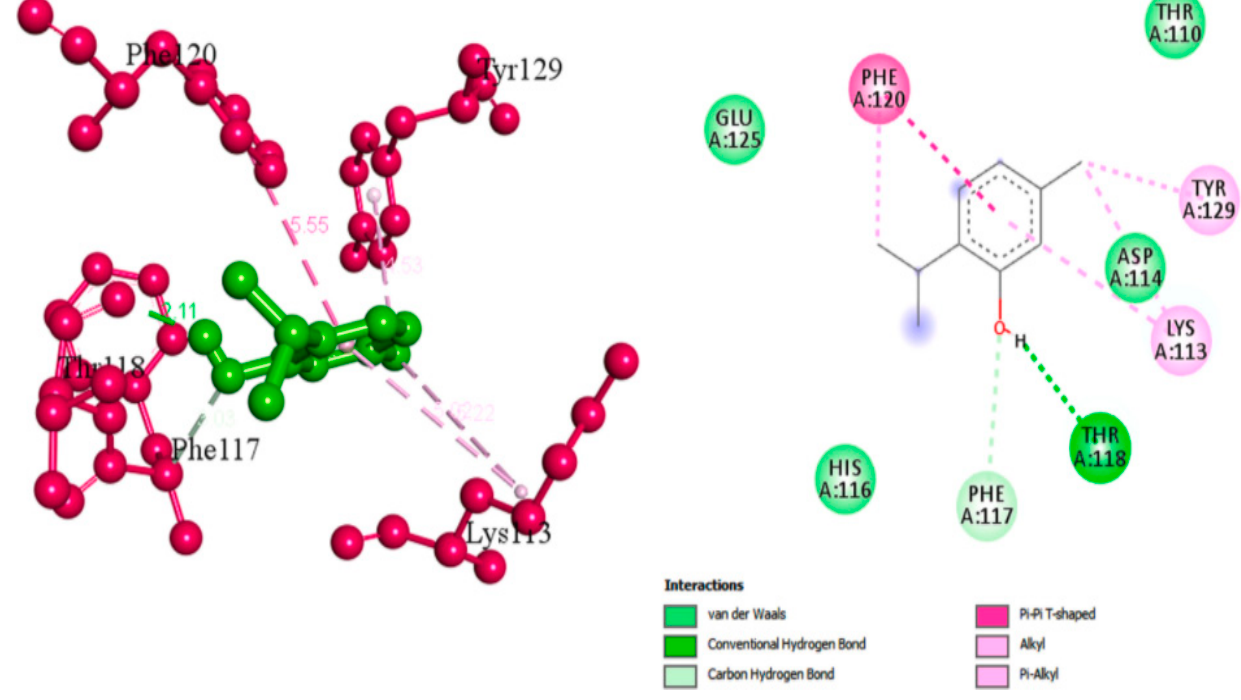
Figure 4. Molecular docking analysis showing 2D (on the right panel) and 3D (on the left panel) representation of interaction patterns of thymol with dehydrosqualene synthase receptor [49].